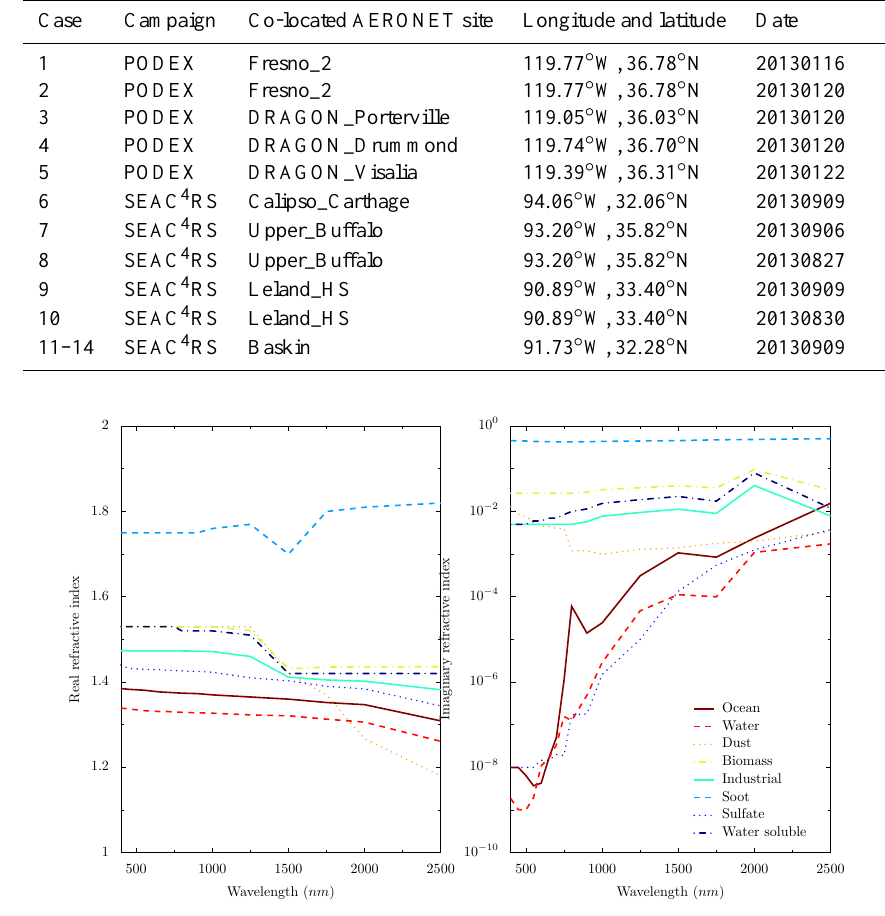
Figure 2. Imaginary (left panel) and real parts (right panel) of the refractive index as a function of wavelength. Data taken from D’Almeida et al.